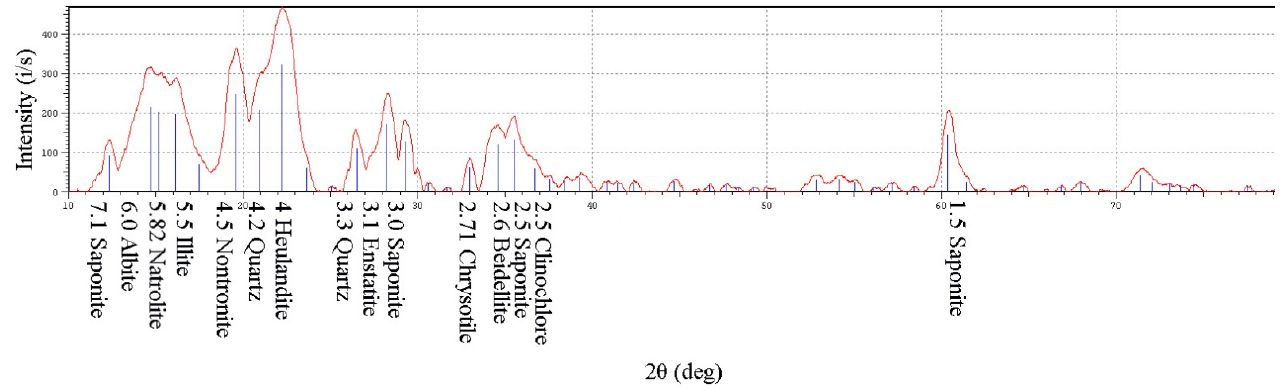
Figure 2. The ore mineral composition.